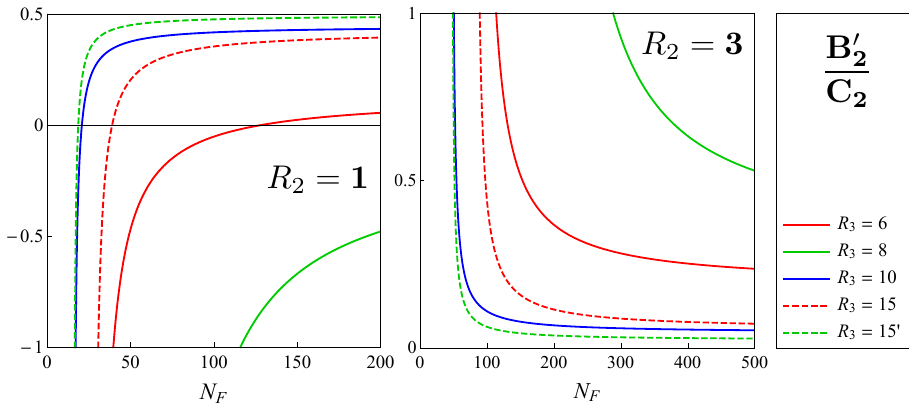
Figure 3 . Asymptotic freedom at partially interacting (cid:12)xed points FP 3 . Shown is the condition for asymptotic freedom (3.17) for the e(cid:11)ective coe(cid:14)cient B 0 in units of the two loop coe(cid:14)cient 2 C 2 > 0 at FP 3 for, exemplarily, R 2 = 1 (left panel) and R 2 = 3 (right panel), and as a function of R 3 (color coding given in the legend). We observe that asymptotic freedom in the weak sector is regained as soon as R 2 > 1 and R 3 > 3 , for any N F . For R 2 = 1 , a lower bound on N F is found (left panel). Qualitatively and quantitatively similar results are obtained at FP 2 (not